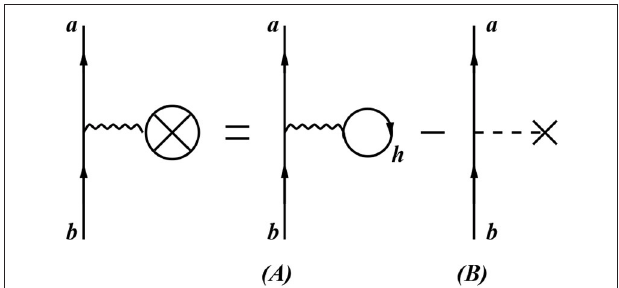
FIGURE 6 | ( V - U )-insertion diagram: graph A is the self-energy diagram, and graph B represents the matrix element of the harmonic oscillator potential U = 1 m ω 2 r 2 2